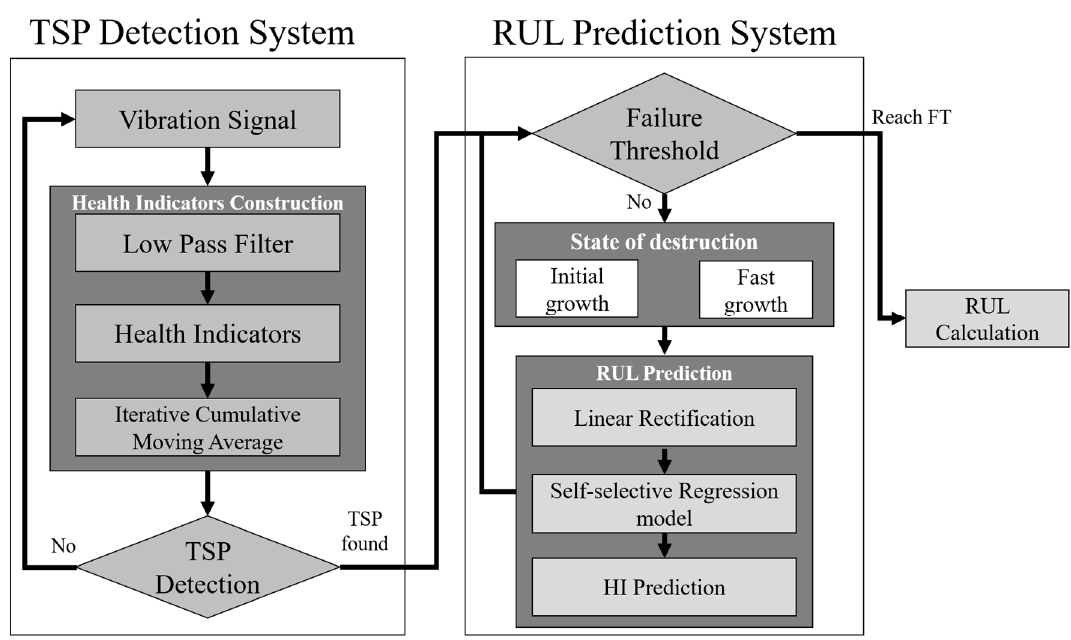
Figure 1. T he proposed bearing RUL prediction